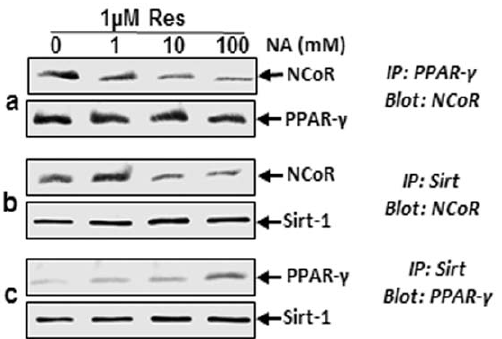
Figure 5. Effect of resveratrol and nicotinamide on association of Sirt-1 proteins with PPAR- c and NCoR in MSC high-density cultures. Cultures were treated with 0, 1, 10, 100 mM nicotinamide or pre-treated with 1 m M resveratrol for 4 h followed by co-treatment with nicotinamide over 14 days with osteogenic induction medium. Cultures were lysed and immunoprecipitated with anti-PPAR- c (a), or anti-Sirt-1 (b, c). The immunoprecipitates were separated by SDS-PAGE and analyzed by immunoblotting using anti-NCoR (a, b) and anti- PPAR- c (c). The same blots were re-probed with an antibody to anti-PPAR- c (a), anti-Sirt-1 (b, c). Results shown are representative of three independent experiments.